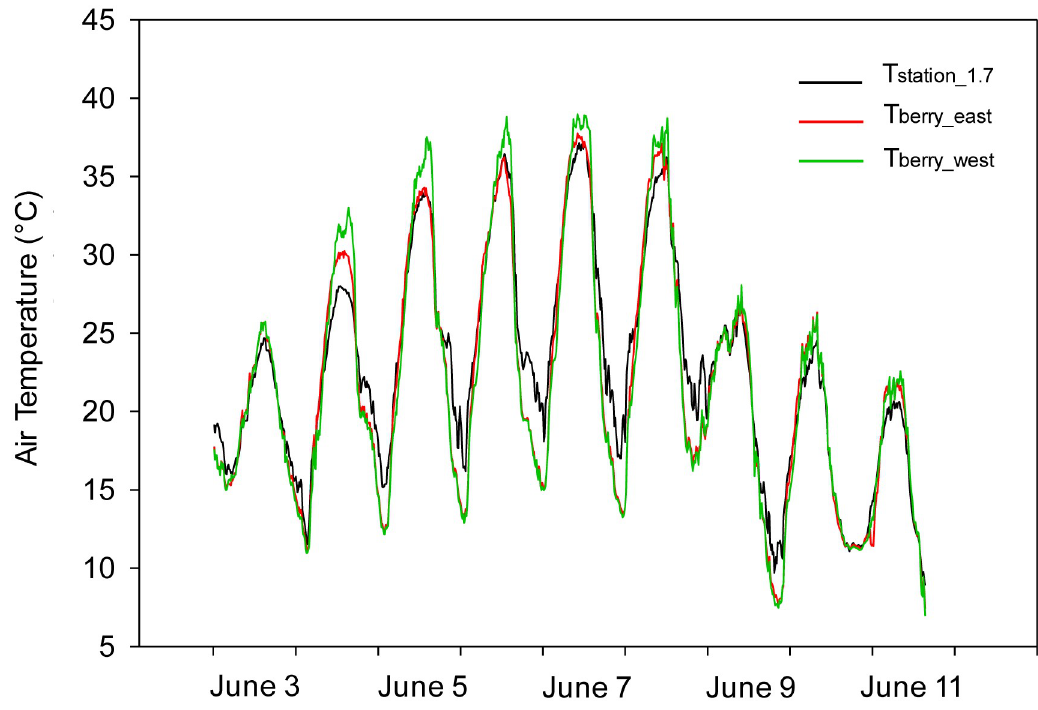
Fig 7. Example time series for 15-min air temperature measured at the weather station (T station_1.7 ) and the grape berry clusters facing east (T berry_east ) and west (T berry_west ) during